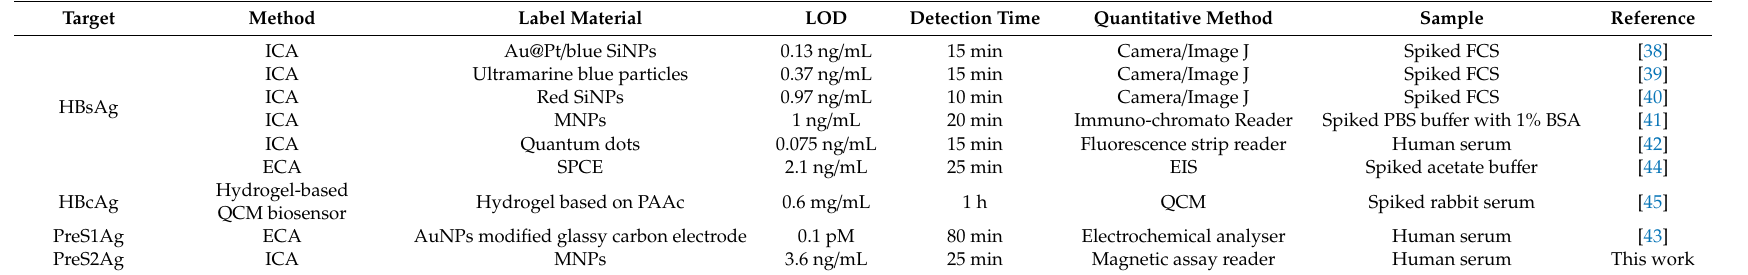
Table 4. Comparison of immunosensors for the quantitative detection of HBV serologic